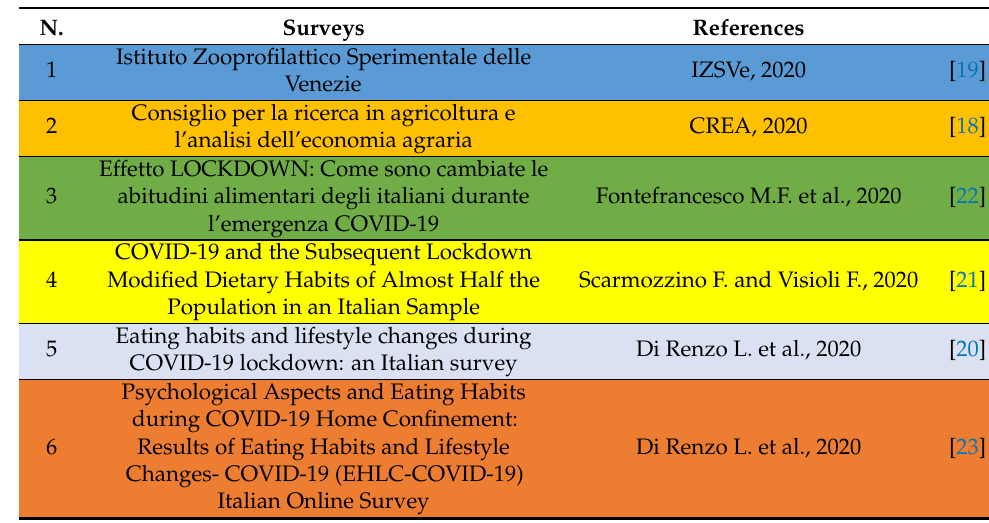
Table 1. The first relevant surveys conducted on Italian consumers. COVID-19, Coronavirus Disease